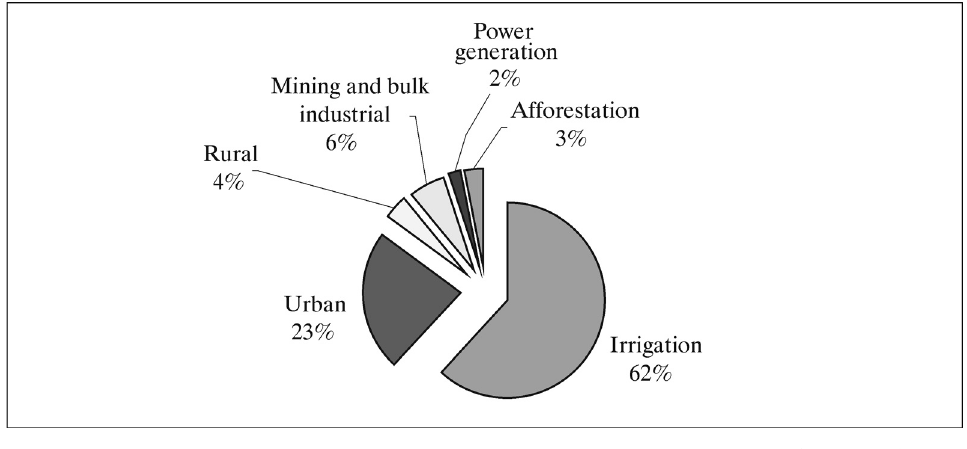
Water requirements by sectors in South Africa: 2000 The following scenarios were extracted from the suggestions proposed by water authorities and experts in South